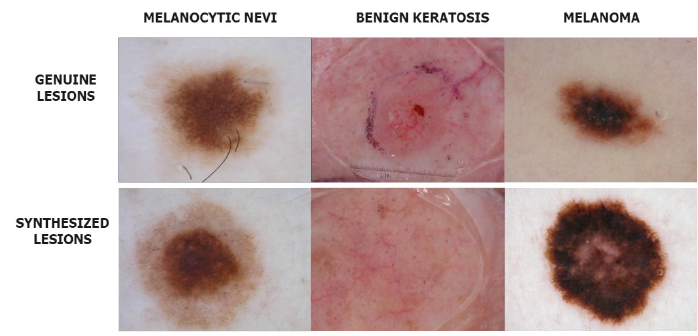
Figure 3. Instances from the Real and Deepfake dermoscopic datasets.